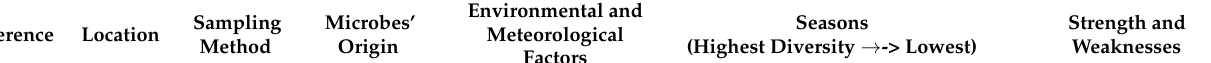
Table 2. Parameters that affect the microbial community: microorganisms’ emission sources, environmental and meteorological factors, and the season in which the alpha diversity was higher reported by each selected paper. Strength (indicated with ) and criticalities ( ) for each paper are reported.